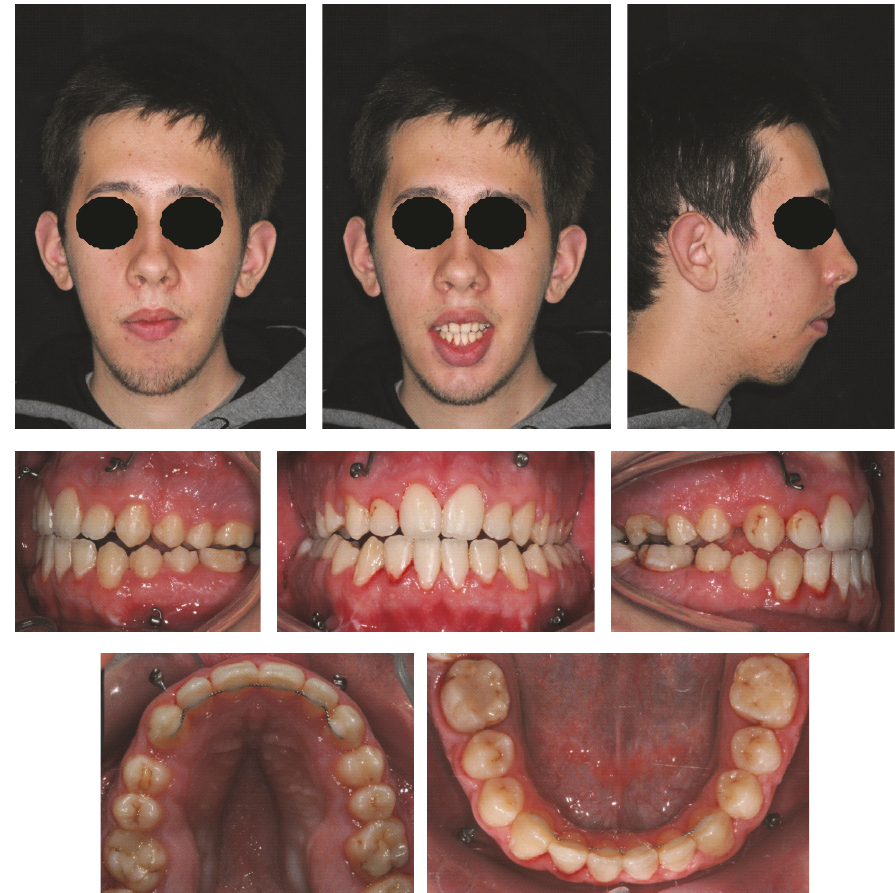
Figure 8: Extraoral and intraoral photographs after orthodontic therapy.